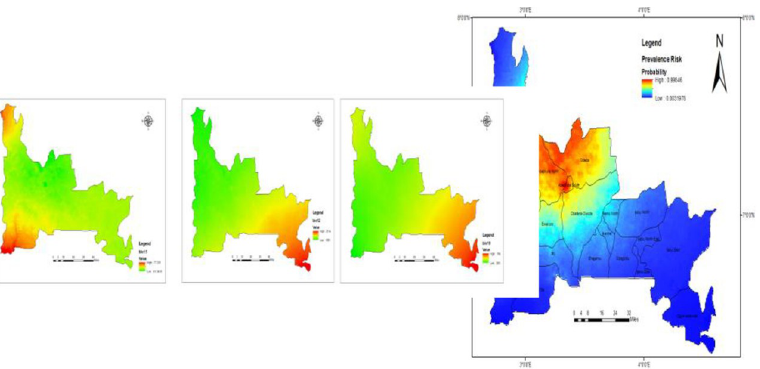
Fig 6. The highest environmental variables that estimate to control the geographical distribution of O . volvulus in Ogun State. Variable contributions (bio15, bio12 and bio19). This figure was created by the authors in R programming software (R version 4.1.2, Vienna, Austria). Available at https://www.R-project.org/. The Nigerian shapefile was obtained from World BankDataCatalog (https://data.humdata.org/dataset/geoboundaries-admin- boundaries-for-nigeria) an Open license standardized resource of boundaries (i.e., state, county) for every country in the world.